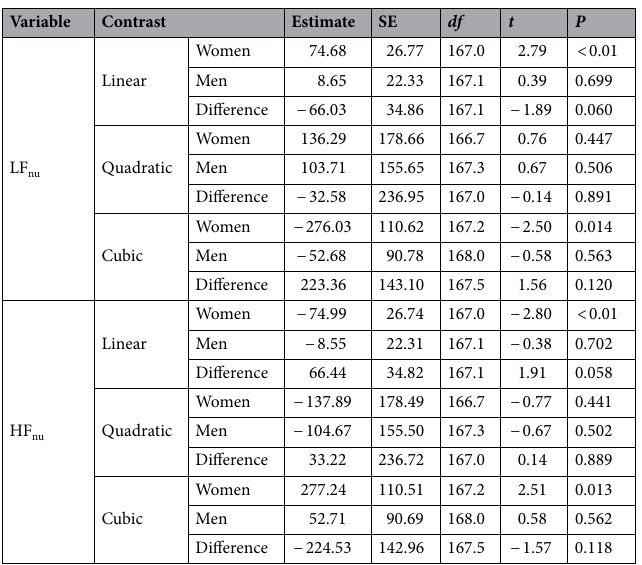
Table 4. Contrasts for assessing linear, quadratic, and cubic trends of expedition on normalized units indices of cardiac autonomic modulation in men and women. Note: SE, standard error; df, degrees of freedom, t , t-statistic for parameter estimate; P , p value.